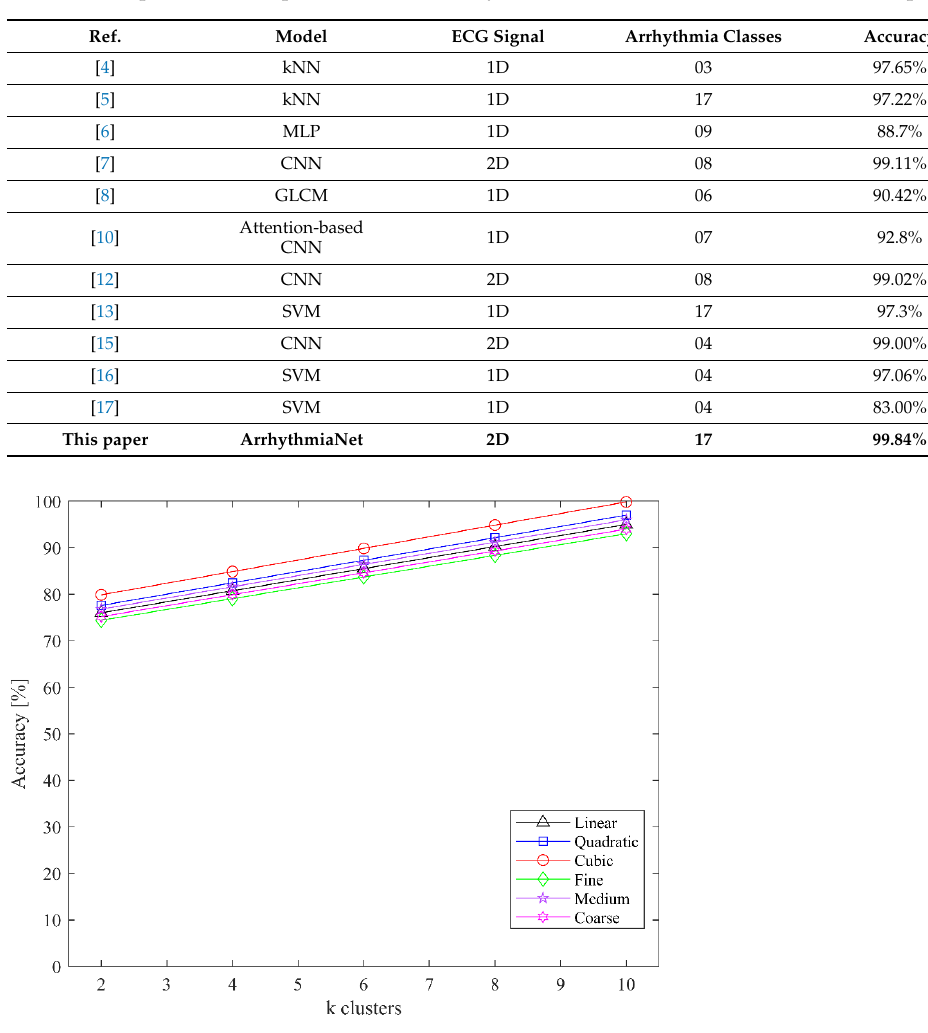
Figure 8. Classification accuracy of SVM for different values of k clusters.